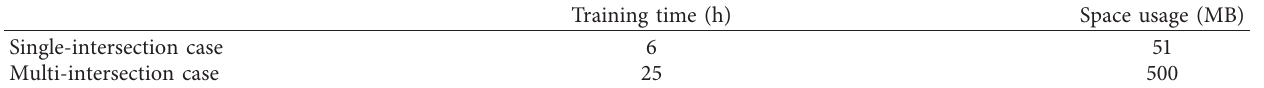
Table 7: Training time and space usage of DQN (ours)